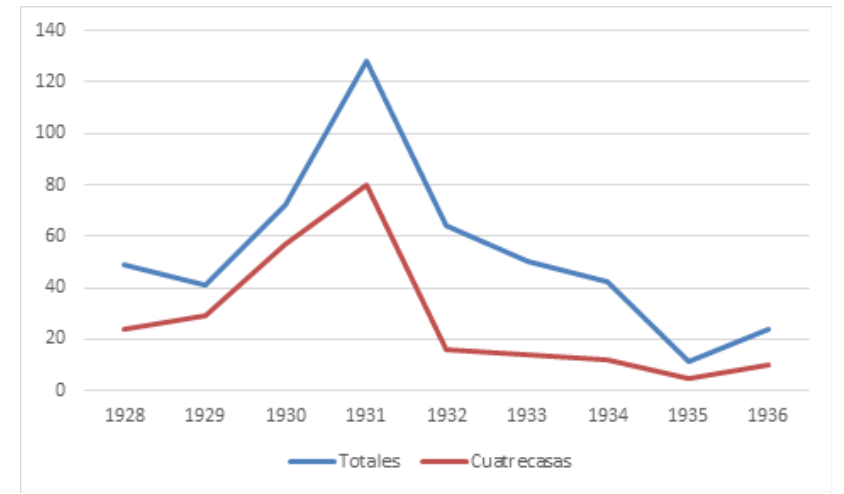
Figure 2. Temporal evolution in the number of bibliographic reviews in Cavanillesia